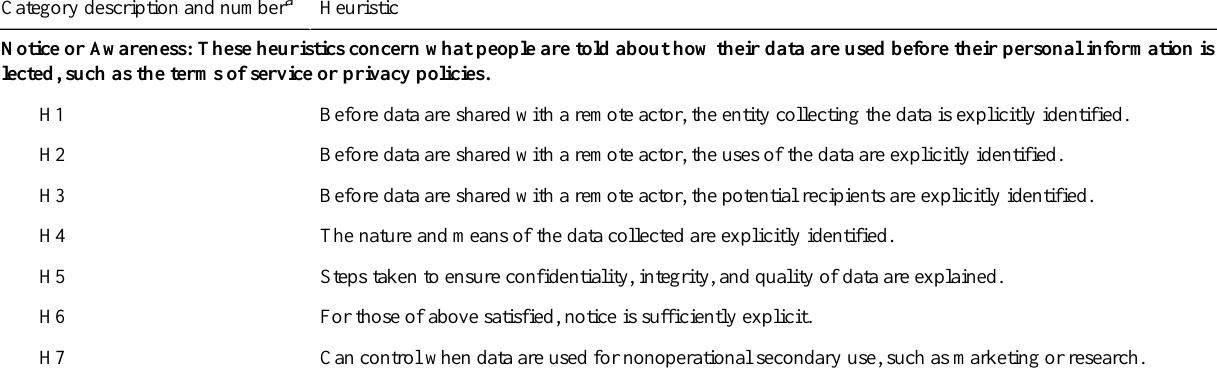
Table 1. The 26 heuristics (H) present in our evaluation technique. HeuristicCategory description and number